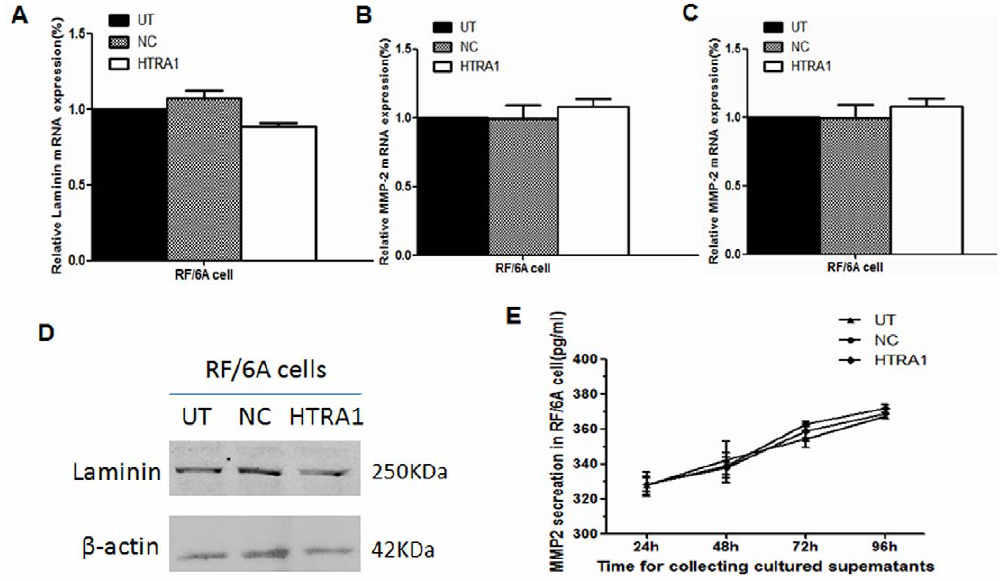
Figure 2. Effect of pGC-FU-3FLAG-HTRA1 on laminin, PDGFR and MMP-2 expression in RF/6A cells as determined by real-time RT- PCR and western blotting or ELISA. Messenger RNA expression of laminin, PDGFR and MMP-2 in RF/6A cells transfected with pGC-FU-3FLAG- HTRA1 showed no significant changes compared with the control groups (A, B, C). No significant differences were noted in the protein expression levels of laminin and MMP-2.